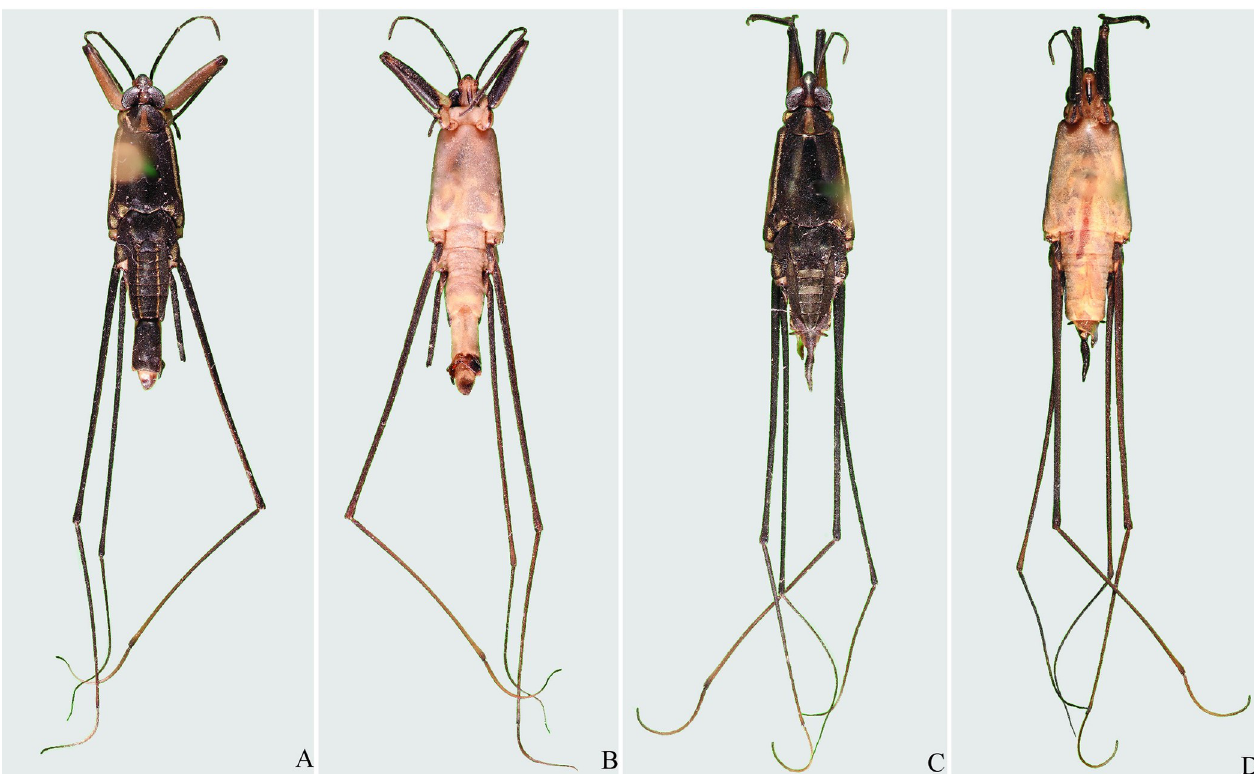
Fig 20. Potamobates spiculus . (A) Male, dorsal view; (B) male, ventral view; (C) female, dorsal view; (D) female, ventral view.